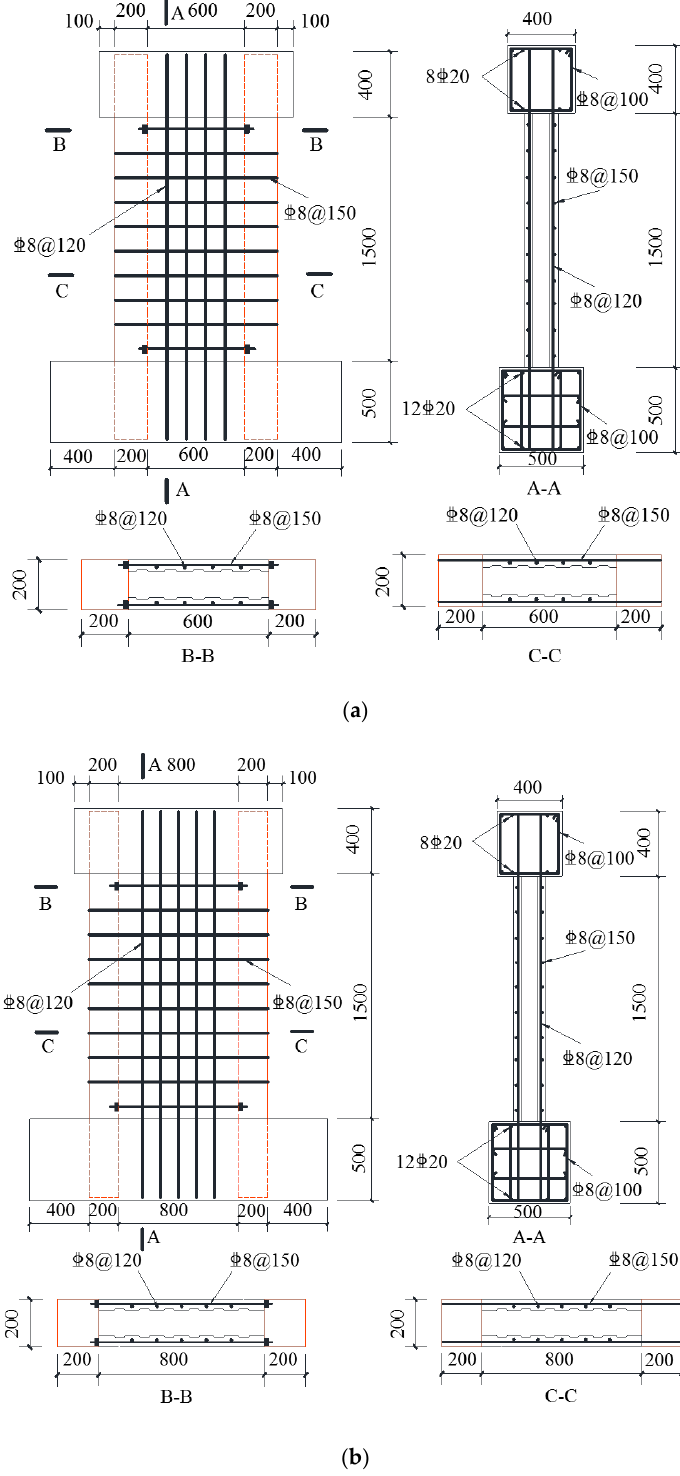
Figure 1. Dimensions and details of Specimen (unit: mm). ( a ) SW1~SW3 specimen design drawings; ( b ) SW4 specimen design drawings.